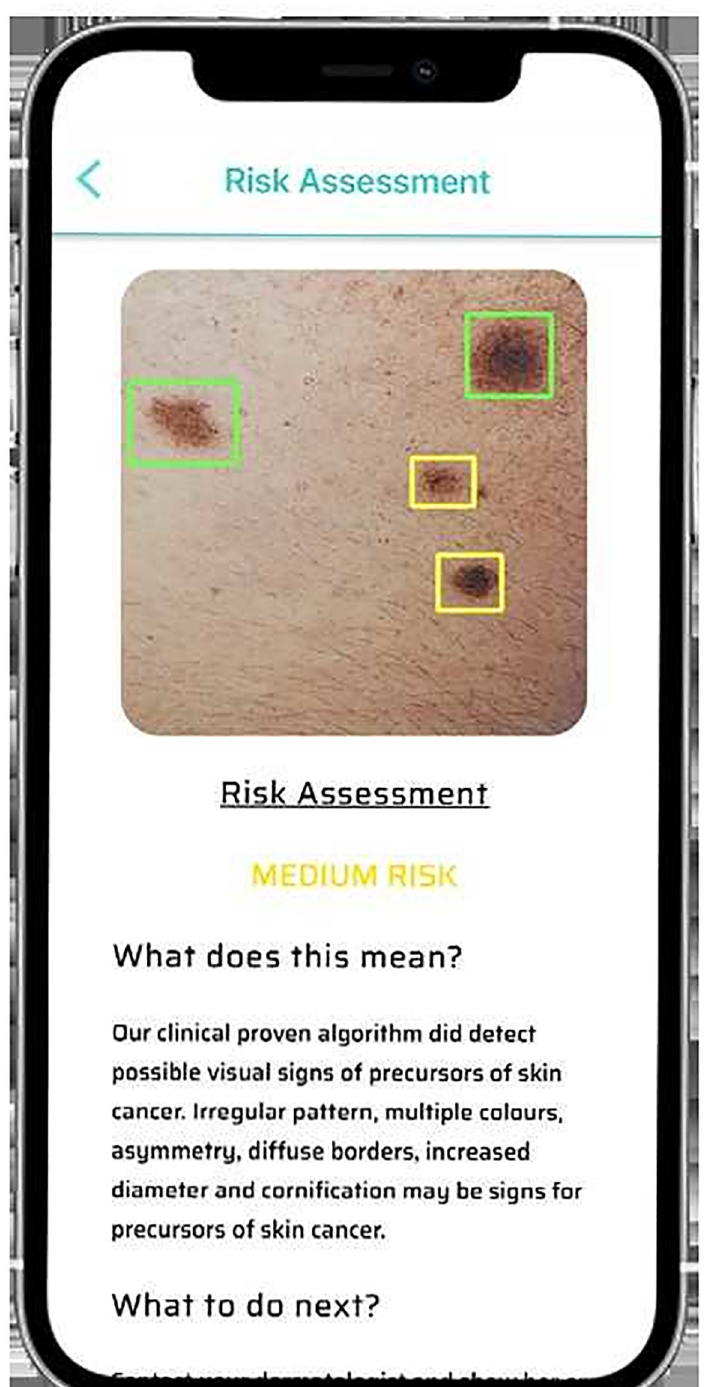
Fig 4. The RPN-based detect algorithm with bounding boxes highlighting the four analyzed lesions of one image. Every detect lesion is assigned to a risk level as indicated by different colors.